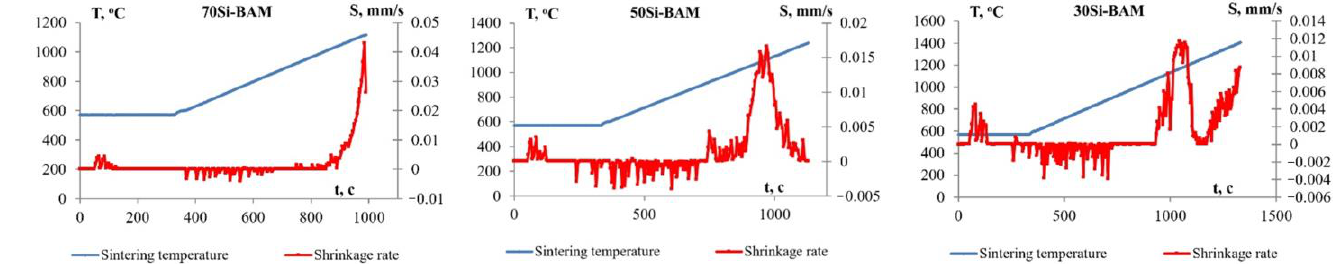
Figure 2. Temperature dependence of shrinkage (L) and shrinkage rate (S) of the Al 12 Mg 17 -B-Si spec- imens.